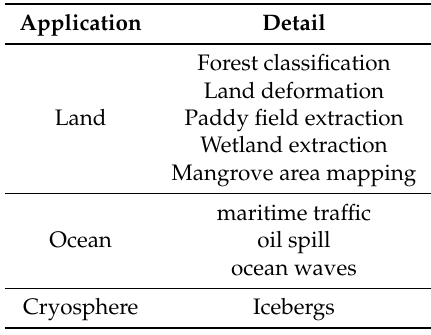
Table 1. Remote sensing applications of the L-band microsat mission.